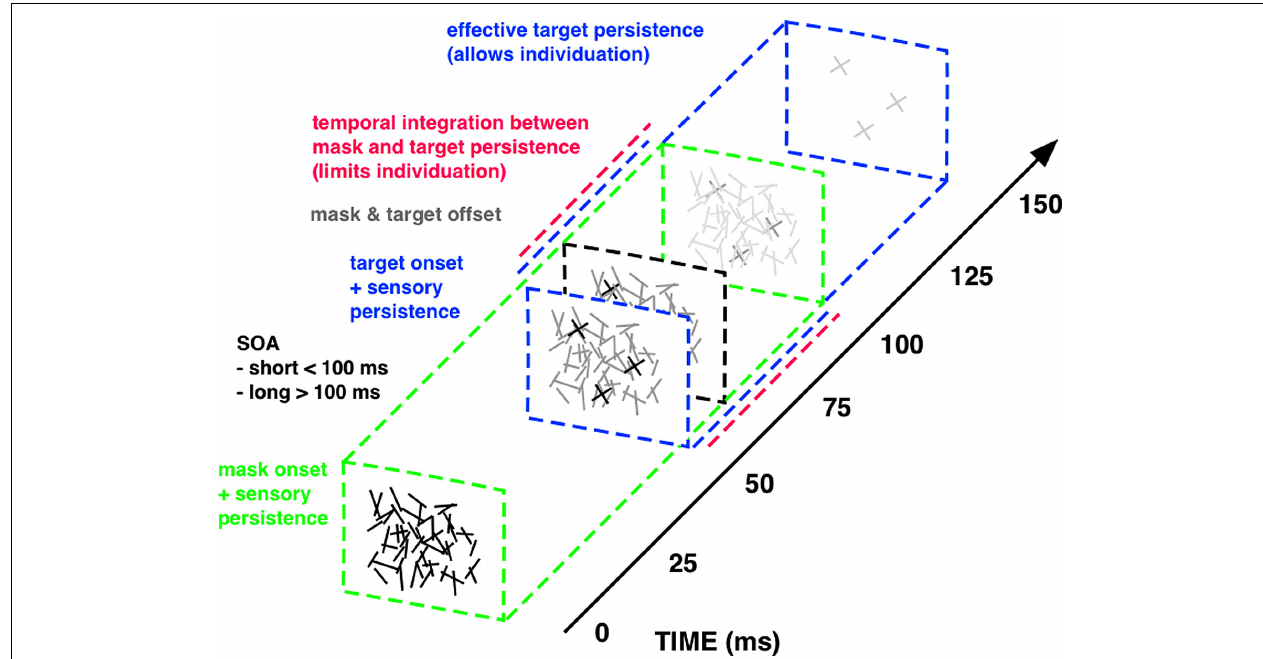
dashed line) occurs for SOAs shorter than around 100 ms, since masking triggered at mask onset continues for this quasi-constant period of sensory persistence (green, dashed line).With longer SOAs the sensory trace triggered at target onset (blue, dashed line) successively segregates from masking persistence and the therein-contained target information can be read-out for an increasingly longer interval.The maximum time window available for target read-out spans the entire effective target persistence (i.e., without integration from preceding masking persistence) of around 100 ms (seeWutz etal., 2012, 2014;Wutz and Melcher, 2013 for details on the masking